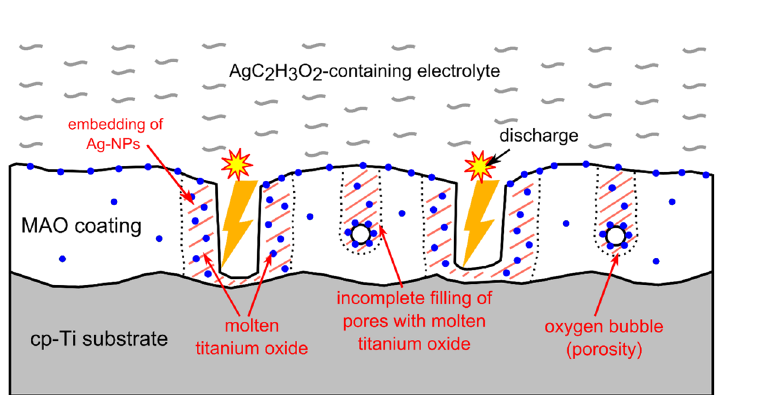
Table 1. Results of the quantitative analysis of the XPS spectra.